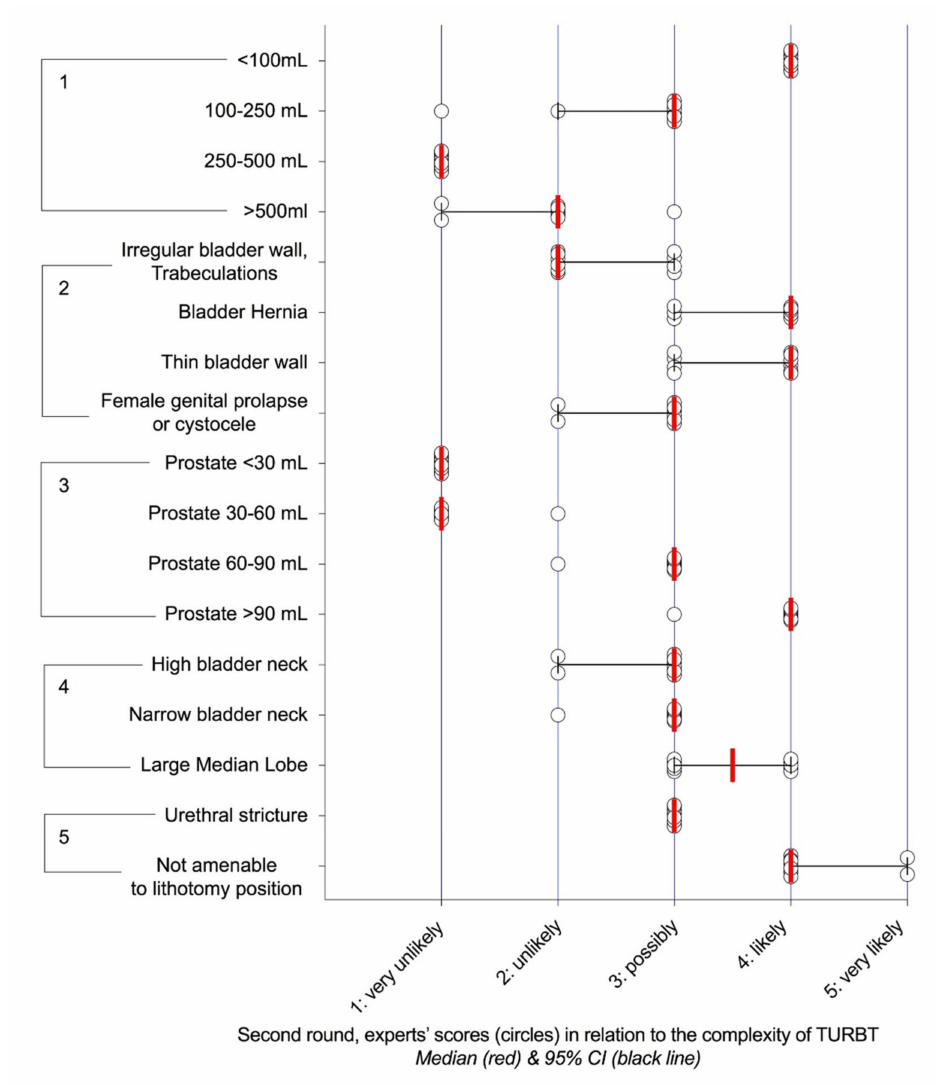
Figure 3. Distribution of the scores regarding the likelihood of incomplete resection and / or prolonged surgery ( > 1 h) and / or significant (Clavien-Dindo ≥ 3) perioperative complications according to bladder characteristics and access to the bladder cavity: ((1) bladder capacity, (2) bladder structure, (3) prostate volume, (4) bladder neck, (5)